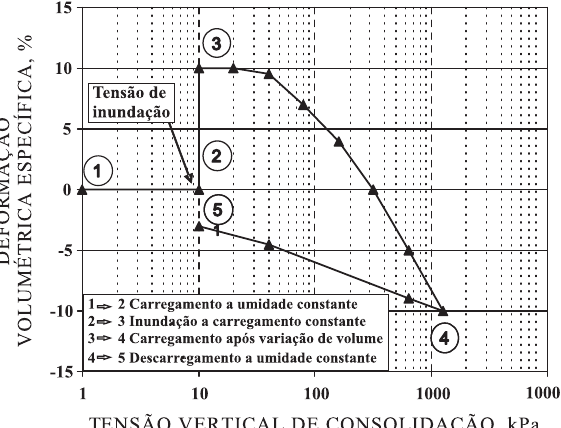
Figura 2. Etapas dos ensaios edométricos